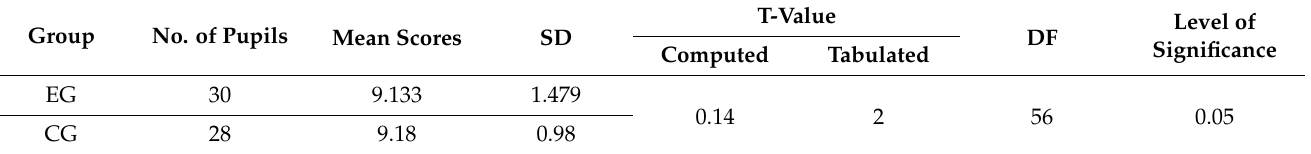
Table 11. The Mean Scores, Standard Deviations, and T-Values of the EG and CG in the First Posttest. Group No. of